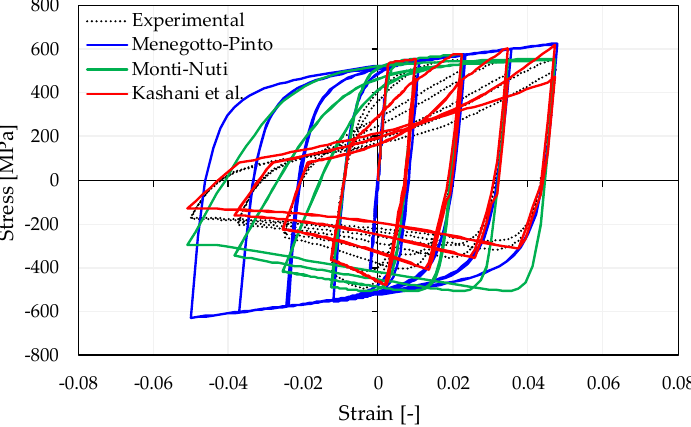
Figure 2. Comparison between non-linear finite element (NLFE) analyses obtained using the PARC_CL 2.1 crack model and experimental results.